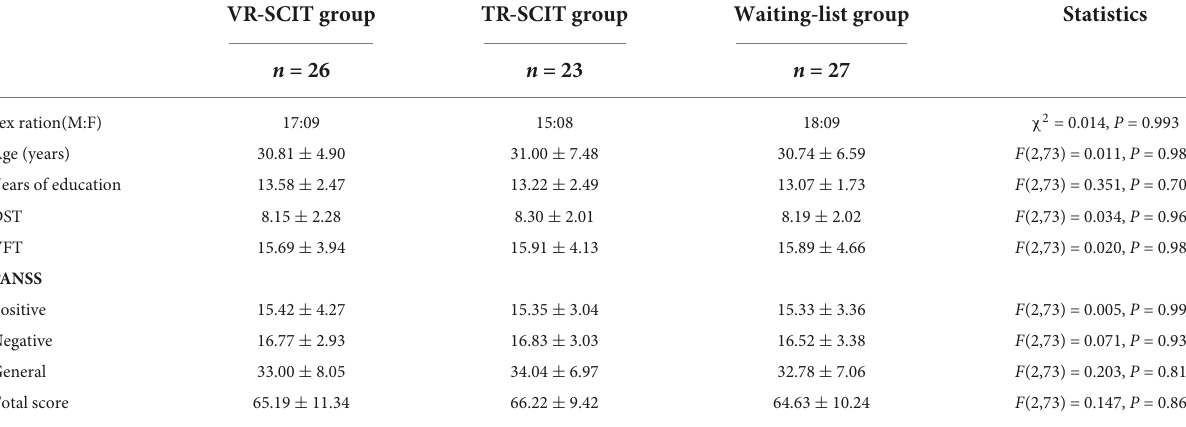
TABLE 2 Demographic and clinical characteristics among groups. VR-SCIT group TR-SCIT group Waiting-list group